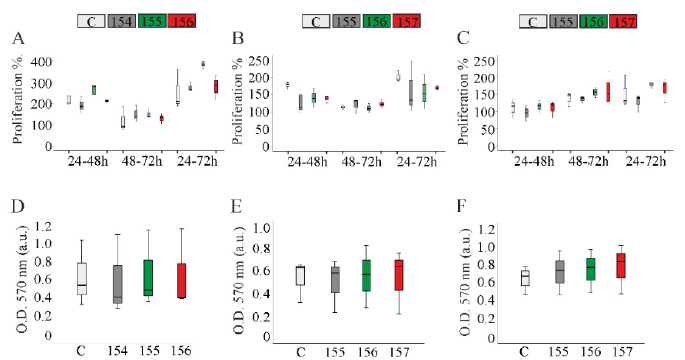
Figure 4. Chemerin does not affect proliferation and viability of hepatocyte cell lines. Proliferation of Hepa1-6, HepG2 and Huh7 cells. ( A ) Hepa1-6, ( B ) HepG2 or ( C ) Huh7 cells were counted 24, 48 and 72 h after transfection and the results are shown as a % of the initial cell number. MTT assay of